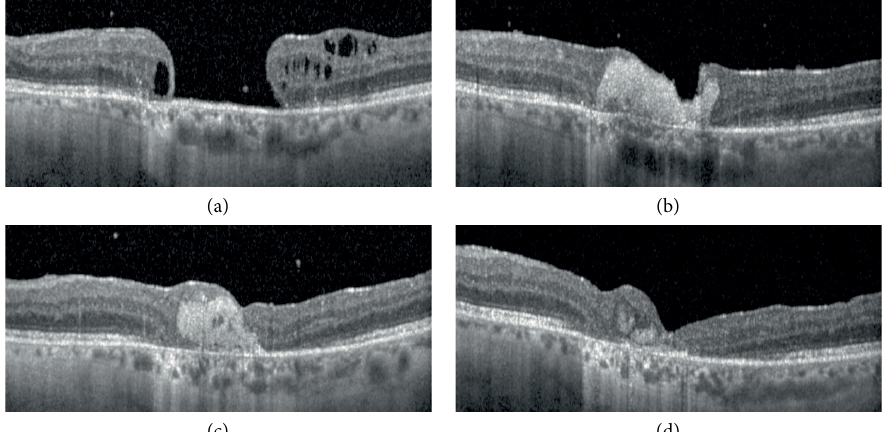
Figure 1: Optical coherence tomographic images of the Case 1 before the operation (a), and one week (b), one month (c), and 3 months (d) after the operation.